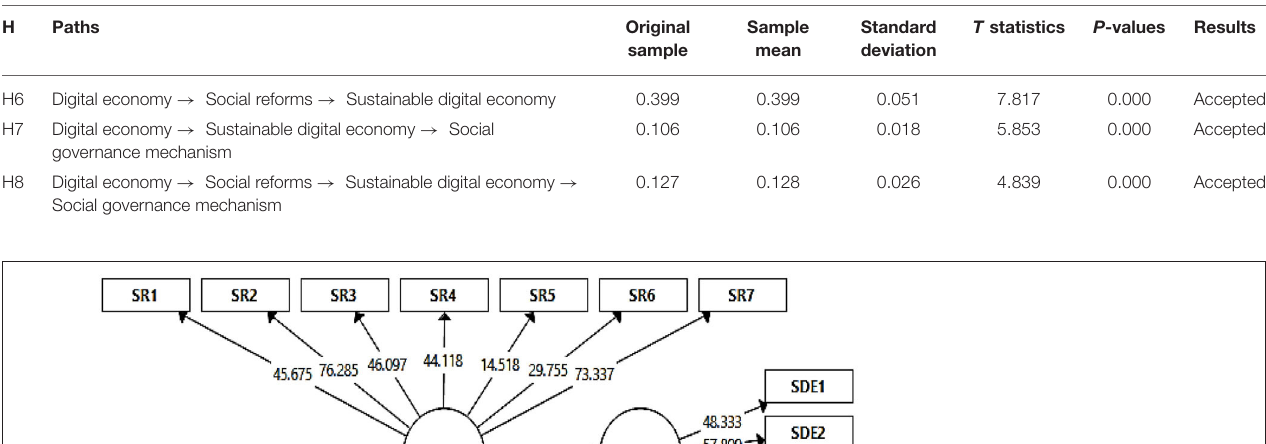
TABLE 6 | Indirect effects.